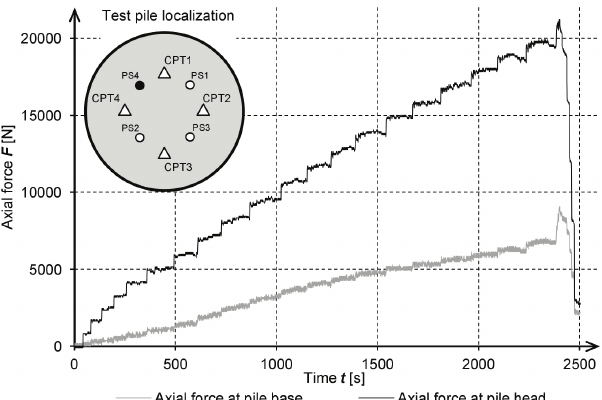
Fig. 4. Soil conditions in single pile and group tests presented as a distribution of q c with CPT tests localization